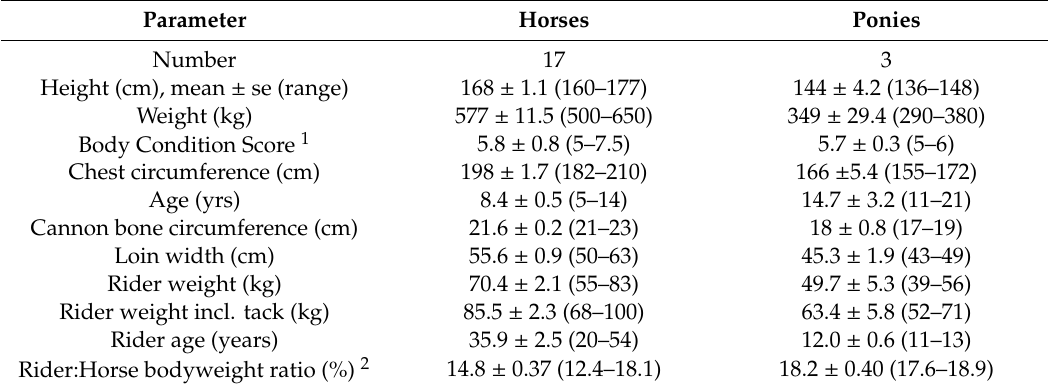
Table 1. Conformation and weight of the horses / ponies and their